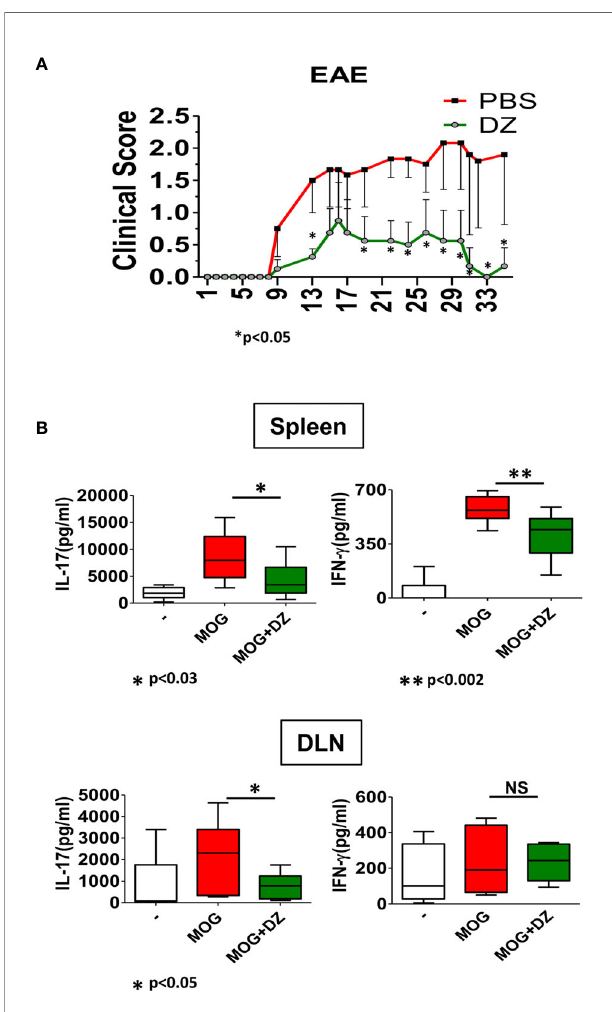
FIGURE 5 | Diazepam treatment reduced the EAE clinical signs and MOG- speci fi c cytokine production. (A) DZ or vehicle was i.p. administered to mice challenged for the disease in alternate days from day 3 p.i. and then were scored daily. Clinical scores of experimental groups were statistically analyzed by Mann – Whitney test, p < 0.05 (B) Production of IL-17 and IFN- g by cells isolated from spleen and draining lymph nodes (DLN) from nontreated EAE animals at 30 dpi and incubated in the presence of MOG (10 µg/ml) or MOG/ DZ was determined. These data are representative of at least 2 experiments. Signi fi cant differences of MOG/DZ- vs. MOG-treated cells are indicated by * p < 0.05 and ** p < 0.01. Non-signi fi cant values are expressed as